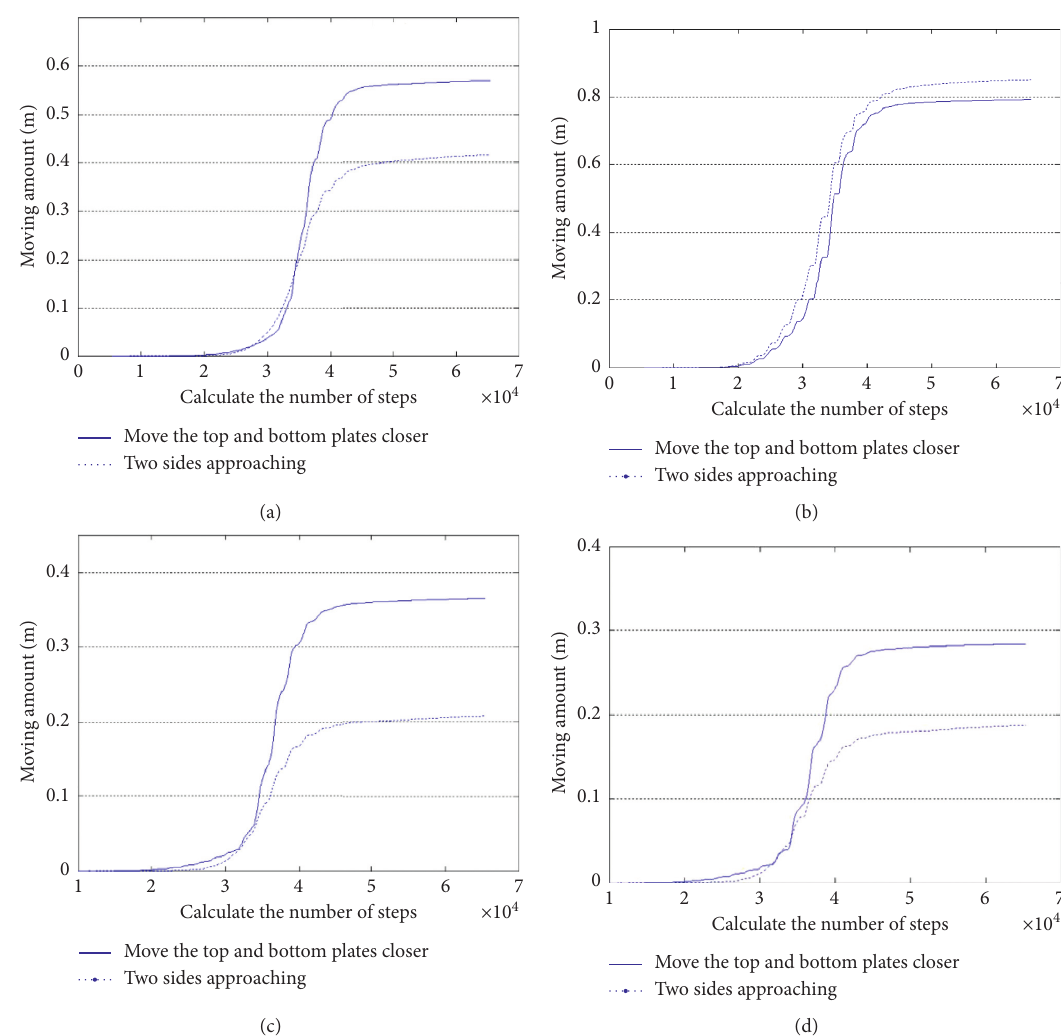
Figure 15: The displacement curve with each scheme. (a) No support. (b) Bolt-mesh shotcreting support. (c) Anchor mesh shotcre- ting+anchor cable. (d) Anchor mesh shotcreting +anchor cable +bottom anchor cable.